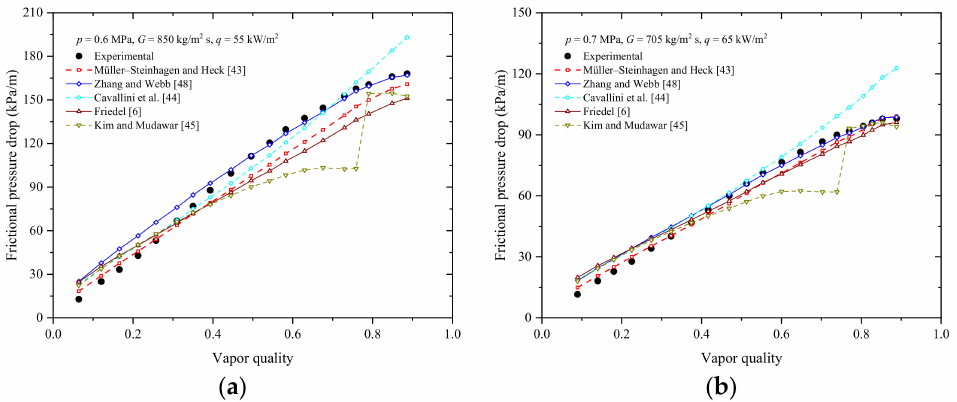
Figure 10. Comparison of FPD trends based on predictive correlations and measured data: ( a ) p = 0.6 MPa, G = 850 kg/m 2 s and q = 55 kW/m 2 ; ( b ) p = 0.7 MPa, G = 705 kg/m 2 s and q = 65 kW/m 2